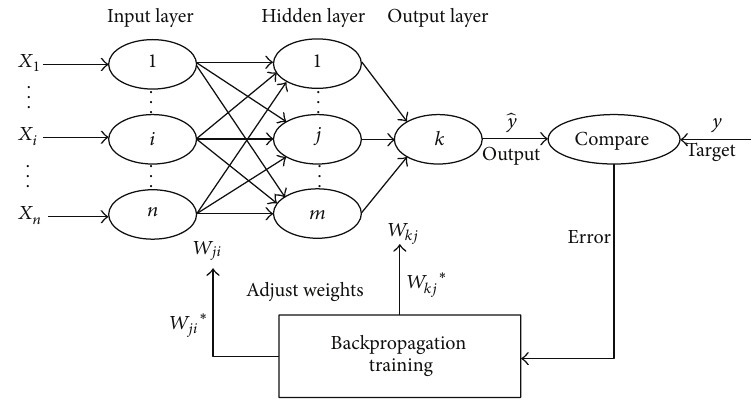
Figure 4: A three-layered FFNN with a backpropagation training algorithm.